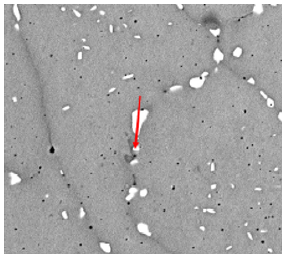
Figure 3. SEM image of CoCrW microstructure.